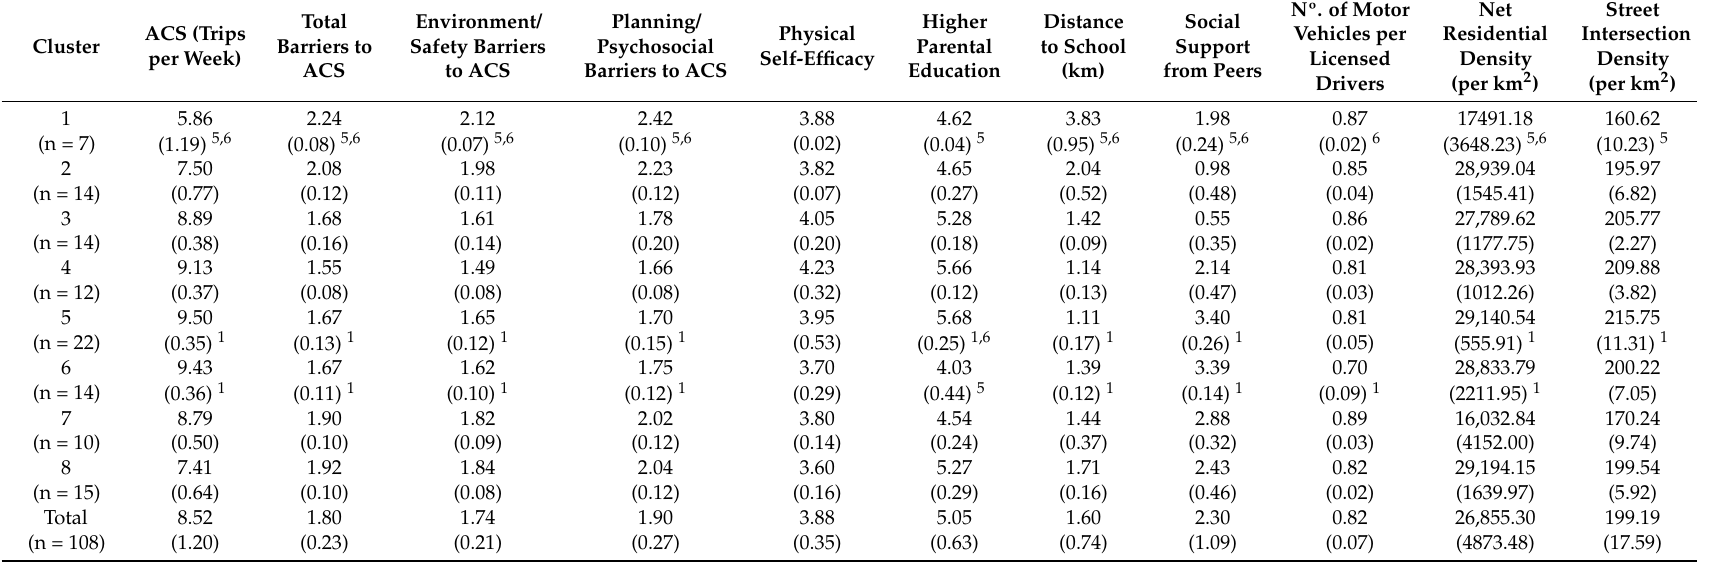
Table 3. Descriptive statistics of the clusters found in this